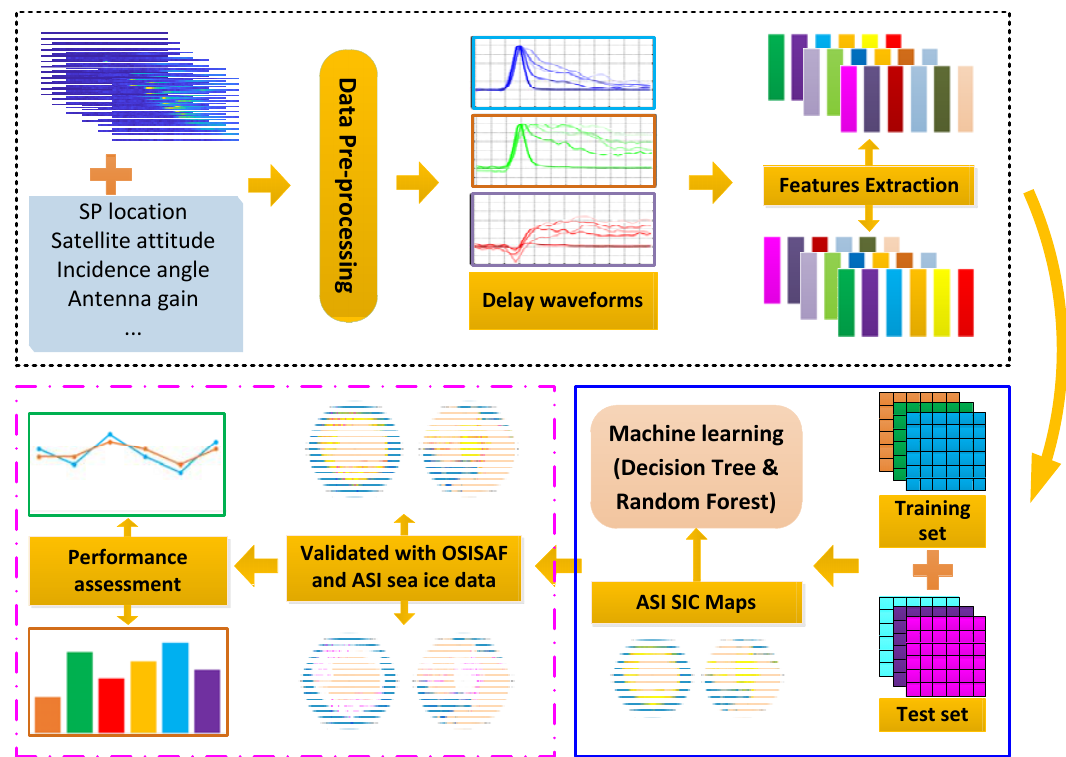
Figure 4. Flow diagram of the sea ice monitoring using machine learning (ML). In the first stage (marked by rectangle with black dashed line), the TDS ‐ 1 data are processed to extract effective features. In the second stage (marked by a rectangle with a blue line), a classifier is developed using the training data, selected feature sequences (i.e., RESC, RESI, RESD, REWC, REWI and REWD) and ML algorithms, e.g., decision tree (DT) and random forest (RF). In the third stage (marked by a rectangle with a magenta dotted line), the classifier is applied to the test data to generate the sea ice monitoring results and evaluate the performance through comparing with the OSISAF and ASI sea ice data.